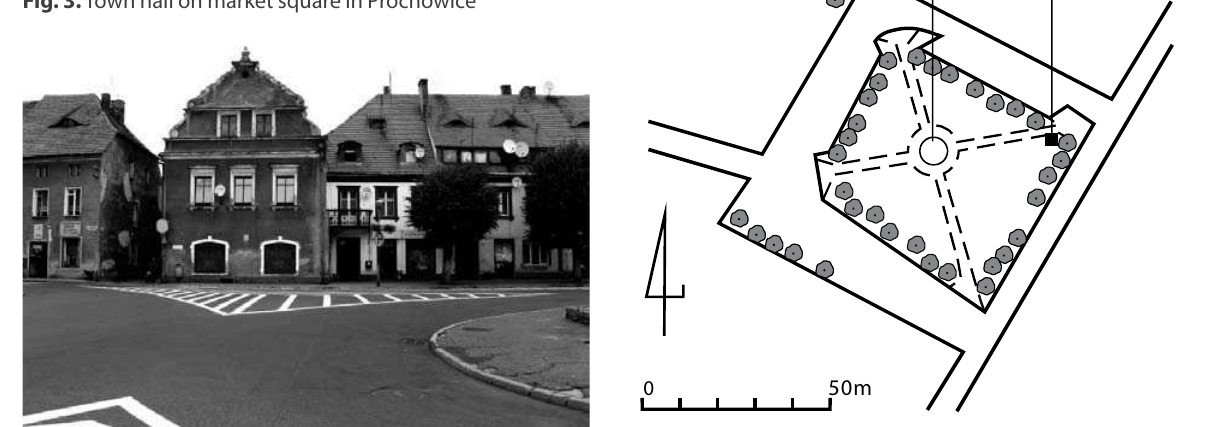
Fig. 4. Frontage of market square in Prochowice, to the left from a house of 1588